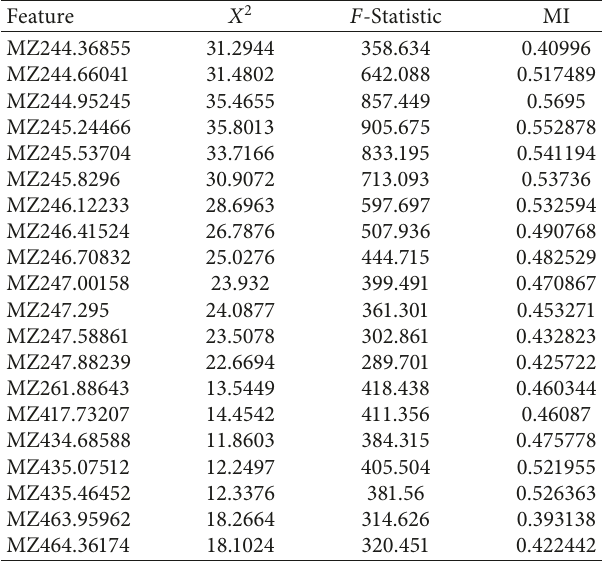
Table 5: Feature rank table (RT) for the ovarian cancer dataset. Evaluation scores are converted to ranks, with 1 being the highest